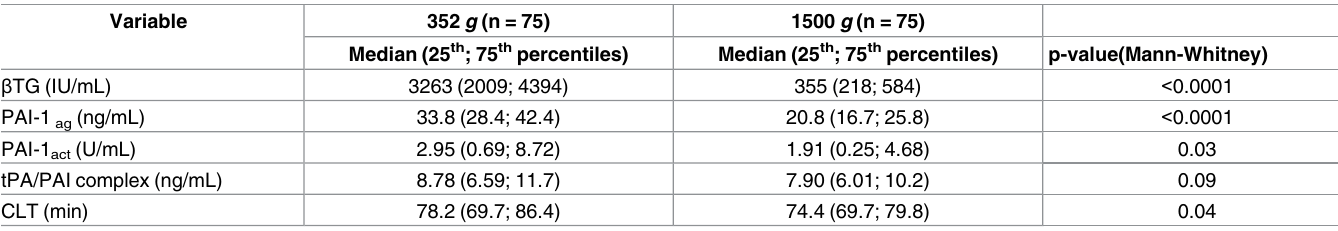
Table 1. Comparison of β TG, PAI-1 assaysand CLT according to centrifugation speed in SABPA study.